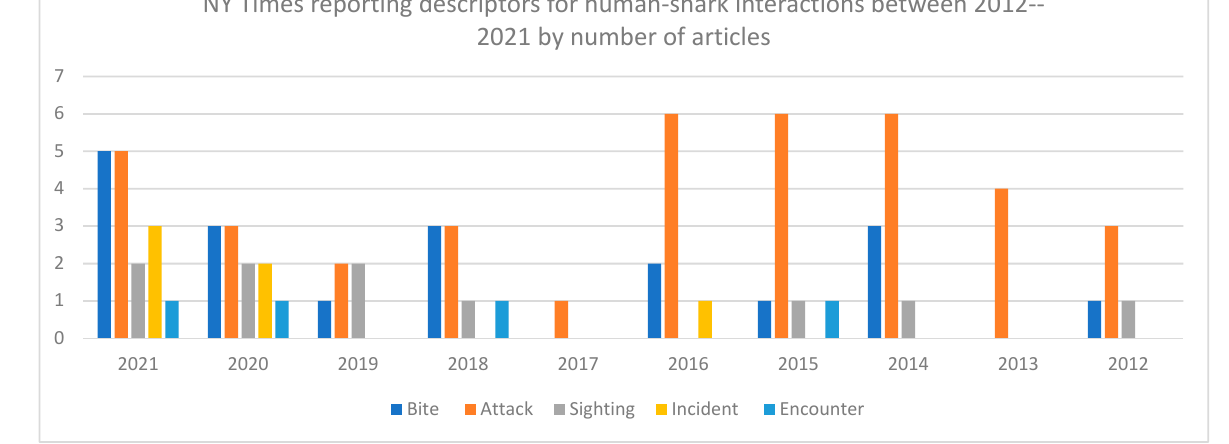
Figure 4. Number of descriptors mentioned per year in The New York Times articles (n = 36).